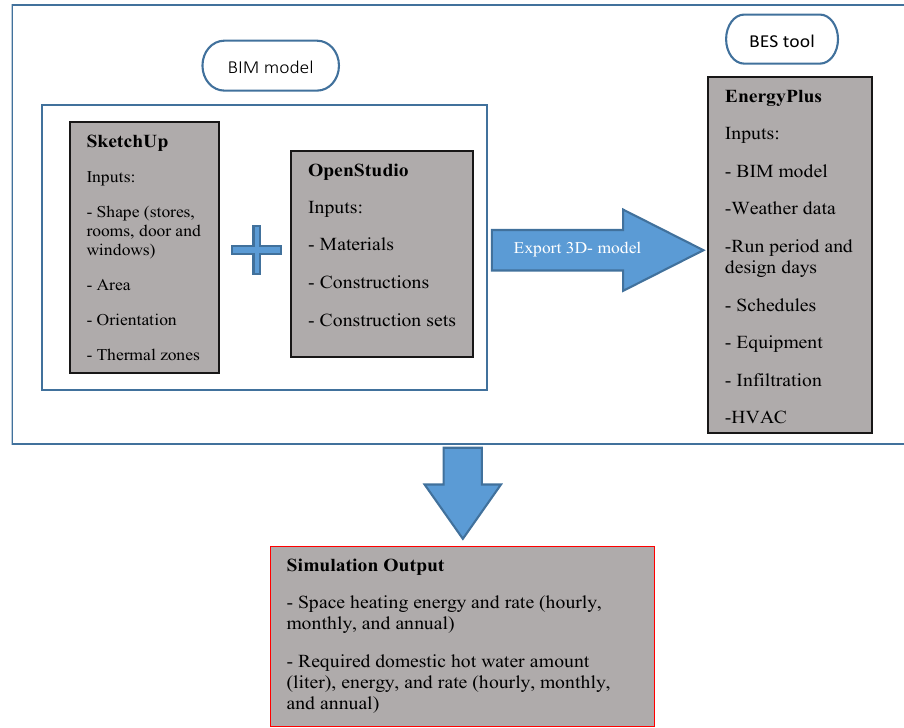
Figure 5. The simulation procedure in SketchUp, OpenStudio, and EnergyPlus.